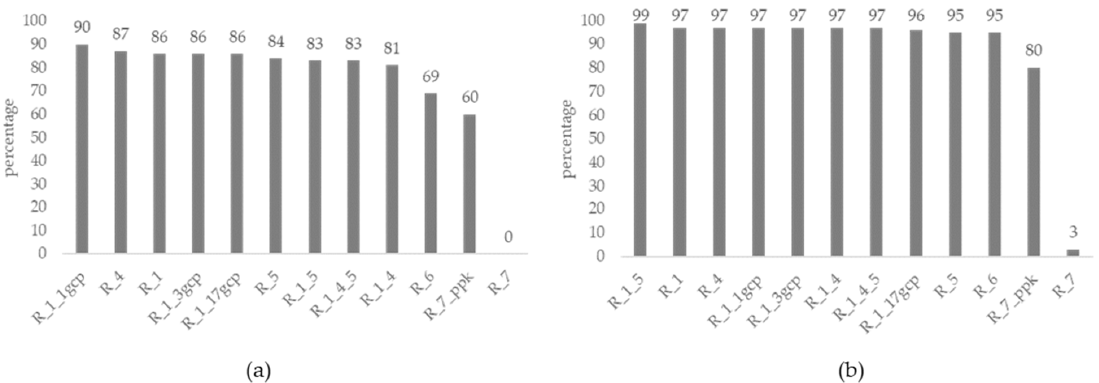
Figure 29. Percentage of the 70 maize plants where HE ≤ distance, for each of the 12 reconstructions. ( a ) HE ≤ 5 cm; ( b ) HE ≤ 10 cm. Figure 29b is the same graph as Figure 29a, but considering a distance between zero and ten centimeters. In this case, for all reconstructions based on D-RTK2 or Teria acquisitions, the percentage is between 95% and 99%, for R7_ppk it is 80%, and it is 3% for R_7 GNSS mode.